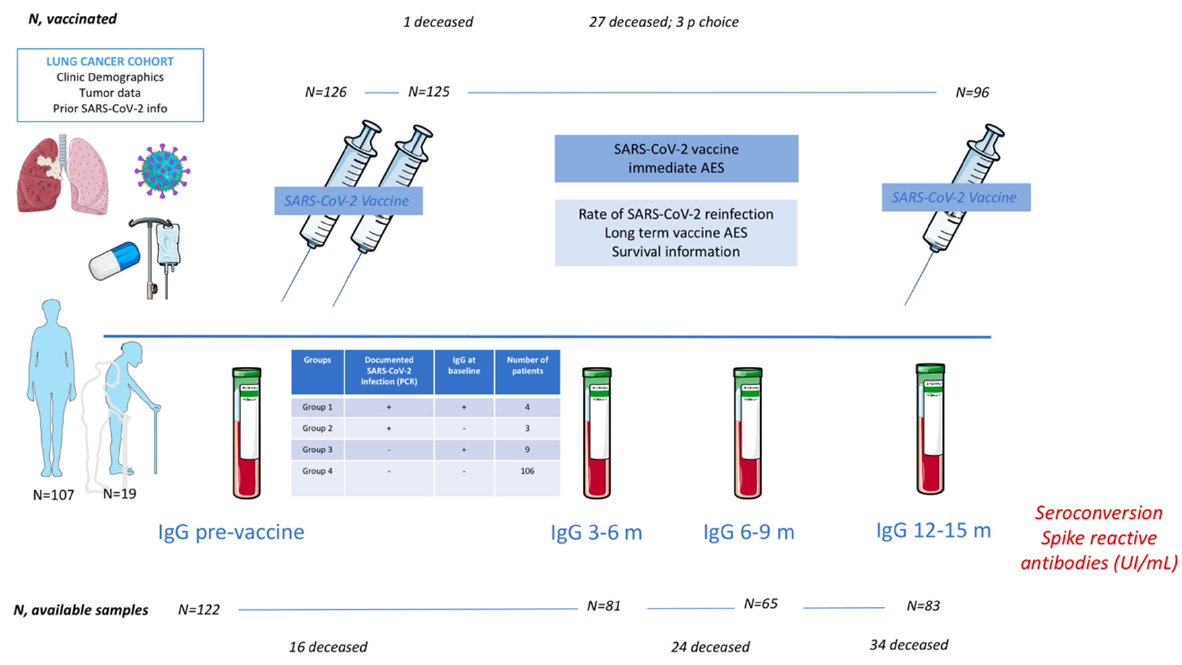
Figure 1. Effect of COVID-19 vaccination in lung cancer patients: COVID Lung Vaccine Study Scheme and patient disposition. Legend: AEs: adverse events; IgG, Immunoglobulin G; n, number of patients; PCR, polymerase chain reaction.